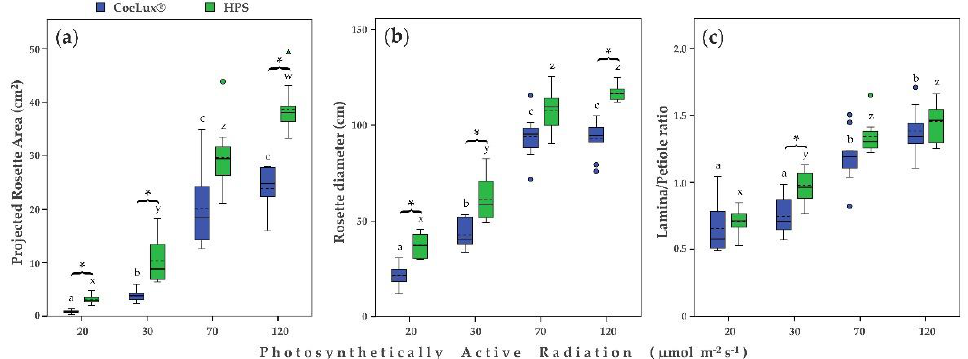
Figure 2. ( a ) Leaves biomass (g), ( b ) root biomass (g), and ( c ) shoot-to-root ratio for different light intensities. Blue and green bars indicate data of plants grown under the CoeLux ® and the HPS light type, respectively. Black asterisks indicate statistically significant differences ( p < 0.05) between plants grown under the CoeLux ® and the HPS light type within the same light intensity. Letters indicate statistically significant differences ( p < 0.05) between plants grown under different light intensities within the same light type. Vertical boxes represent approximately 50% of the observations, and lines extending from each box are the upper and lower 25% of the distribution. Within each box, the solid horizontal line is the median value, whereas the dotted horizontal line is the mean.